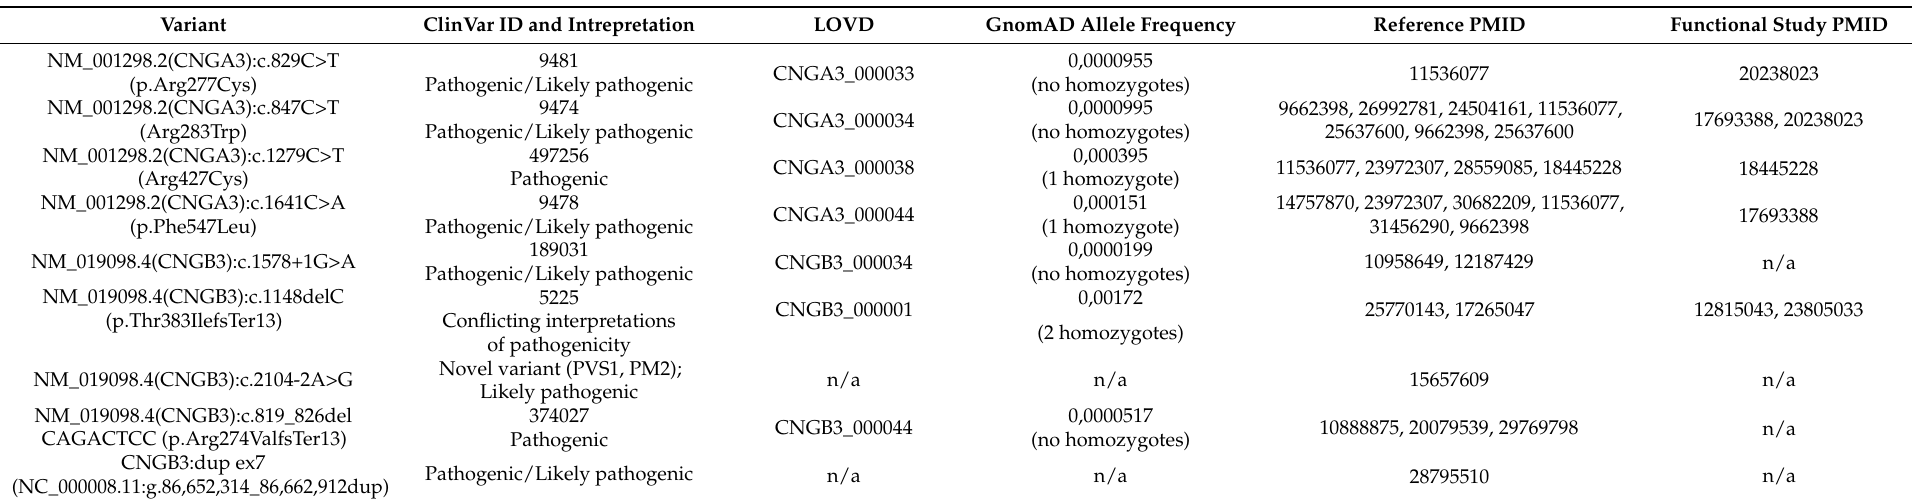
Table 1. Clinical characteristics and genetic findings of the Slovene patients.